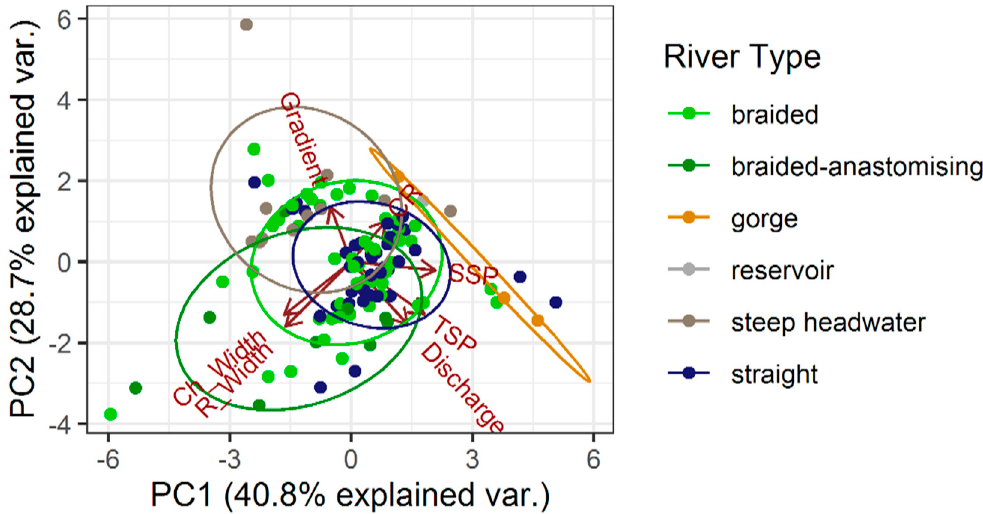
Figure 11. Principle component analysis for the river types and the different river corridor parameters.